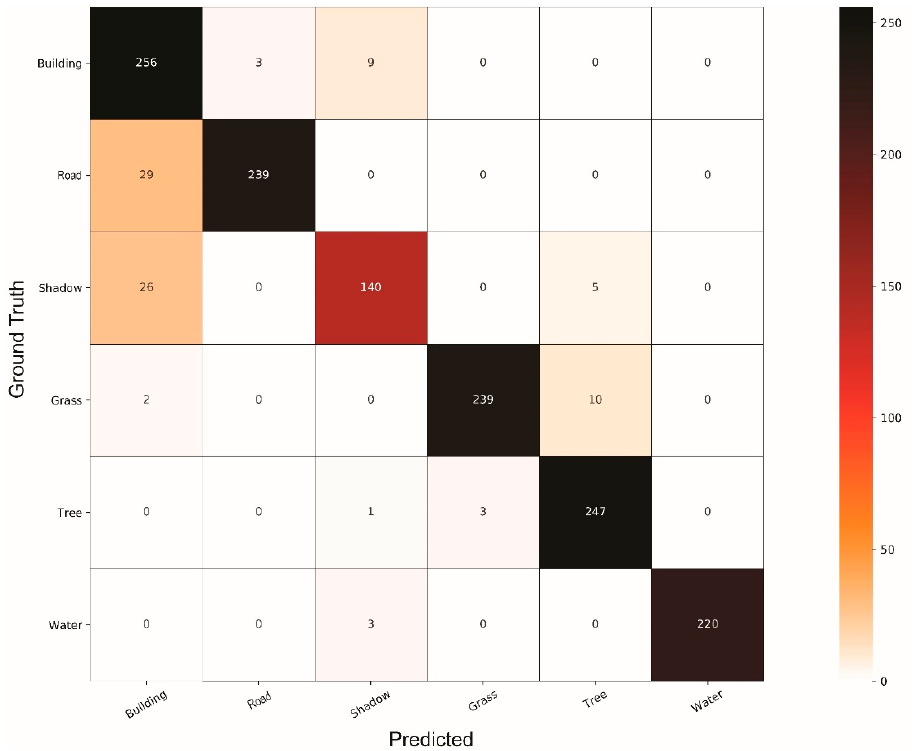
Figure A7. Confusion matrix of the CNN model for 30 cm image.